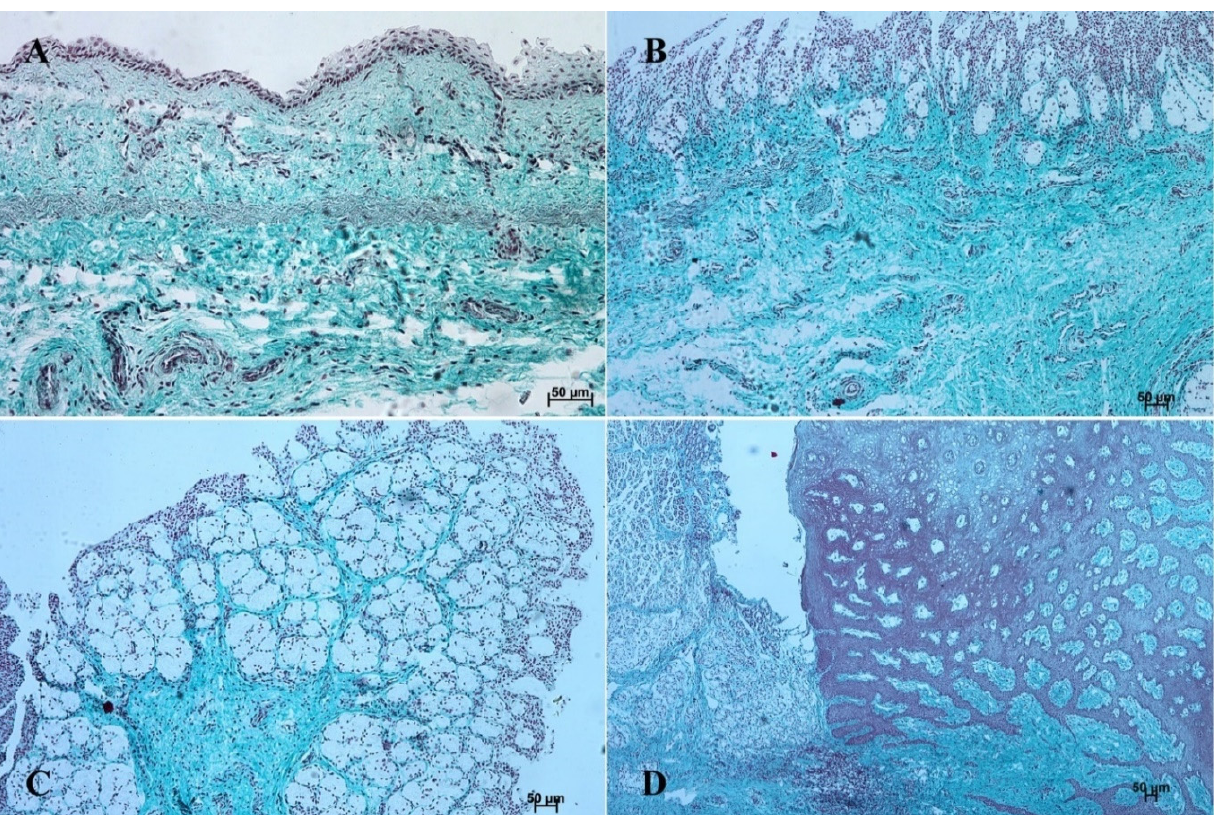
Figure 5. Histological structure of stomach mucosa in the cardiac part (Masson-Goldner staining). ( A )—the first age group (20×); ( B )—the second age group (10×); ( C )—the third group (5×); ( D )—the reference adult group (10×).